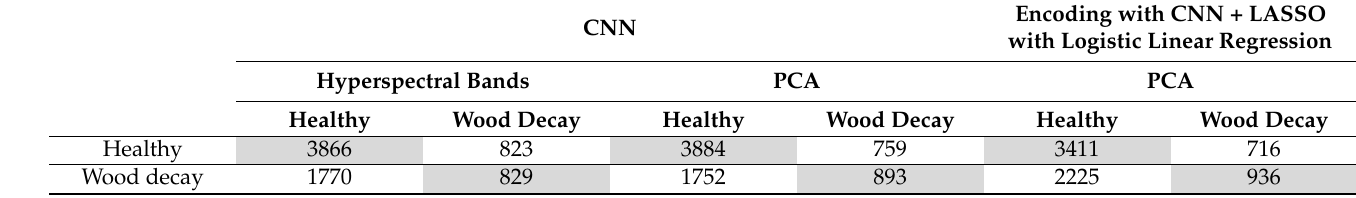
Table 4. Confusion matrices of the models with un-aggregated pixels for Dataset I. The cells with gray background are the main diagonal of the confusion matrices.